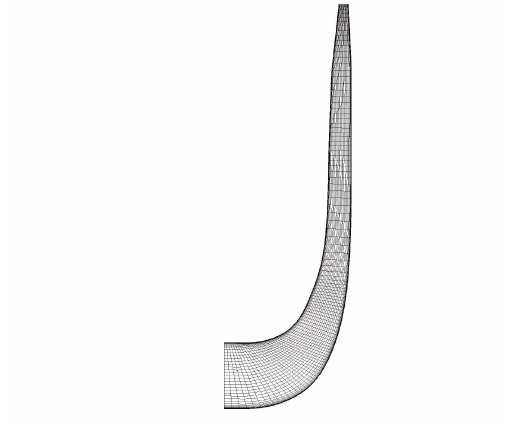
Figure 5: 2D view of the meridional channel